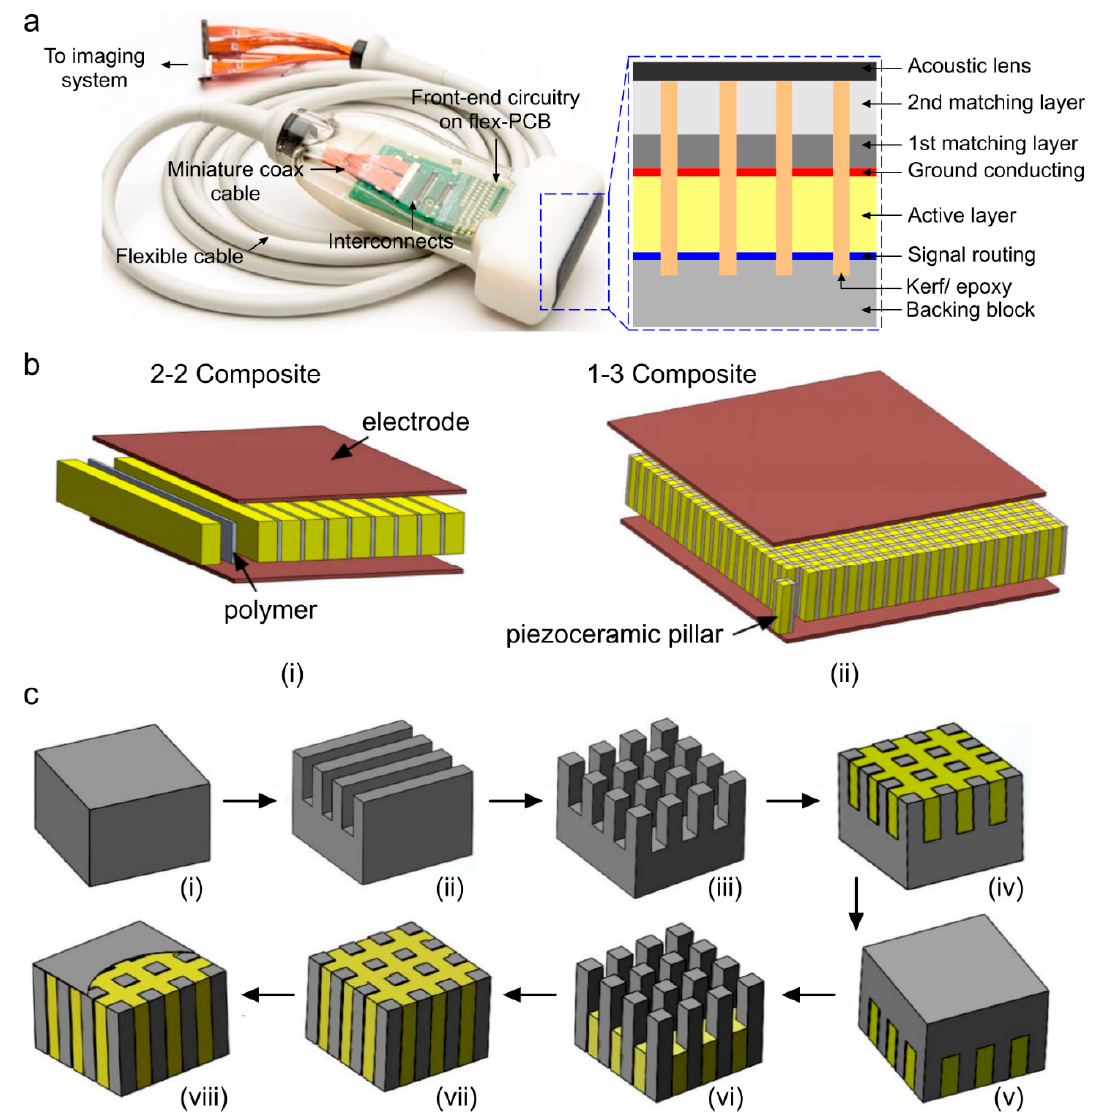
Figure 1. Geometric characteristics and manufacturing steps of a piezoelectric linear array ultrasound transducer. (a) A photograph of a piezoelectric ultrasound imaging probe; the cross-section of the sensing layer is provided in the blue dotted box [39], (b) structural difference between 2-2, 1-3 composite material when used in an ultrasound array transducer [62], (c) process flow of conventional dice and fill (DF) fabrication method using 1-3 composite and epoxy filling that includes: (i) piezoceramic material, (ii) dice in x direction, (iii) dice in y direction, (iv) epoxy filling, (v) reverse, (vi) backside dicing in x and y directions, (vii) 2nd epoxy filling, and (viii) deposit conductive layer. Reprinted with permission from [63].